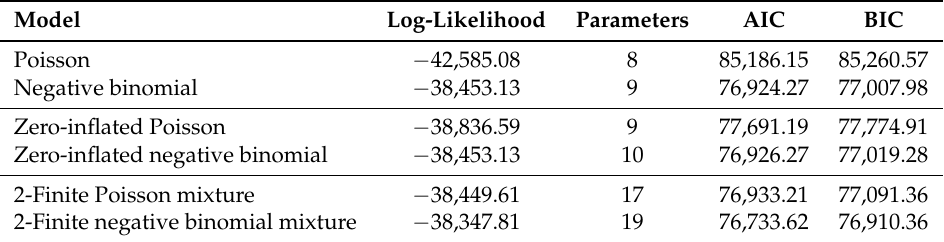
Table 2. Information criteria for selecting the best model for the data.